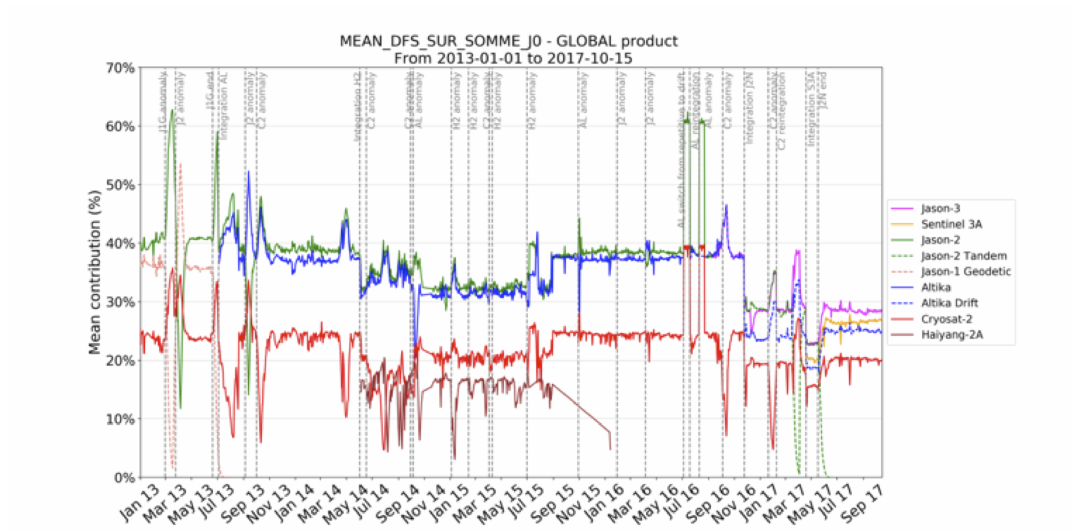
Figure 6. Relative contribution in percentage of each altimeter in the multi-mission NRT DUACS maps during the 2013–2017 period and link with altimeter events. The contribution is derived from the degrees of freedom of signal. The SARAL/AltiKa contribution is in blue, the plain curve corresponding to the repetitive period and the dotted curve to the drifting period.